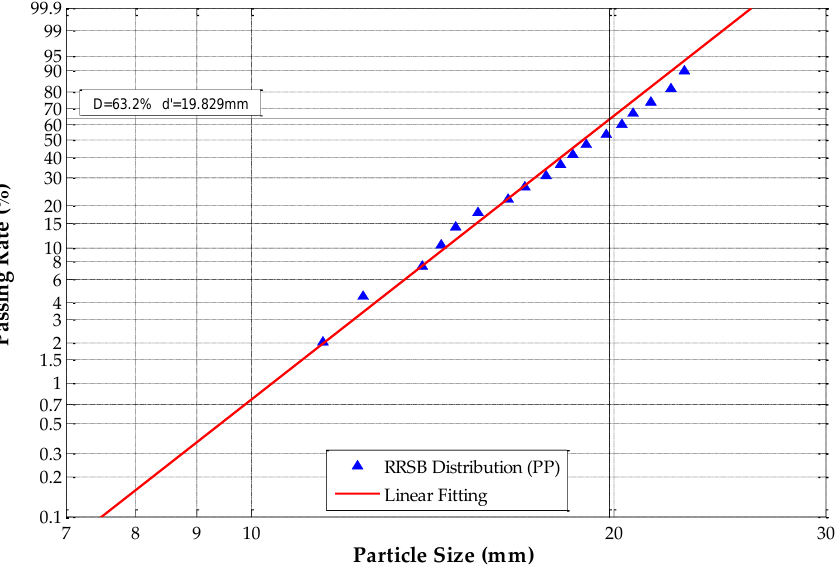
Figure 10. RRSB distribution of polypropylene (PP) scraps.